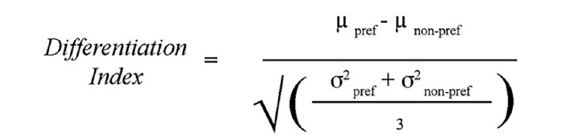
FIGURE 4 | Differentiation Index: used to calculate the degree to which task-associated ROIs were uniquely recruited for the preferred task compared to the non-preferred tasks. For example, the differentiation index for the Location task was computed as the percent signal change within the Location ROI during the Location task minus the average percent signal change within the Location ROI during the Shape and Velocity tasks, divided by the average standard deviation of percent signal change to all three tasks within the Location ROI. Method from Voss et al.